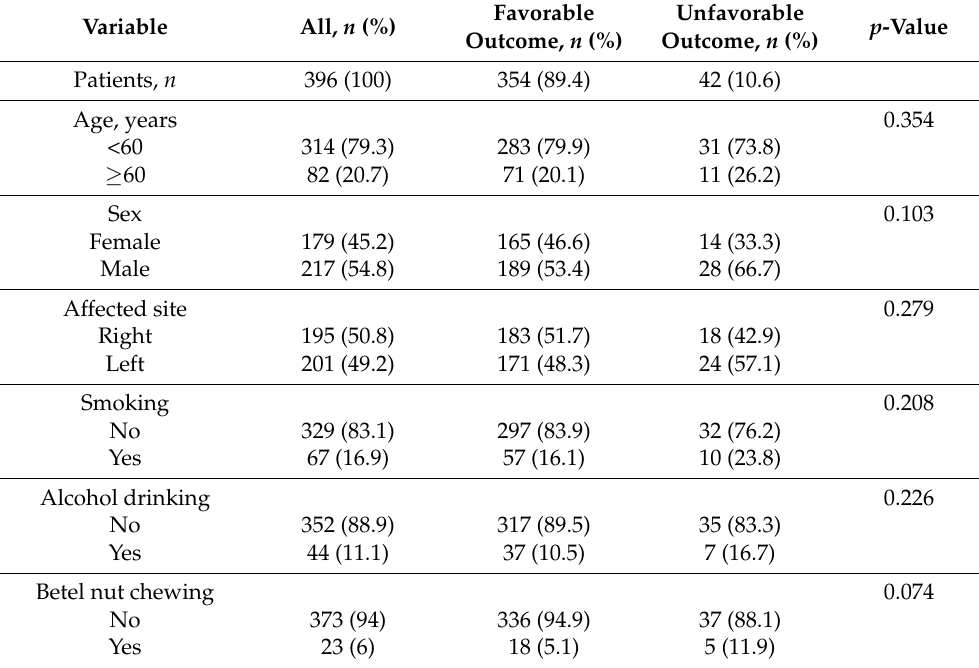
Table 1. Demographic and clinical variables of the patients with idiopathic Bell’s palsy.